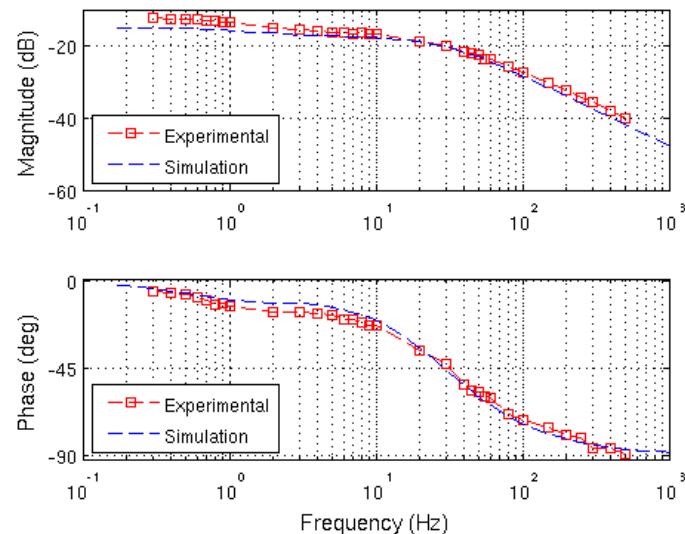
Figure 6. Simulation (blue dashed plot) and experimental (red squares plot) Bode frequency responses in the α - β subspace.